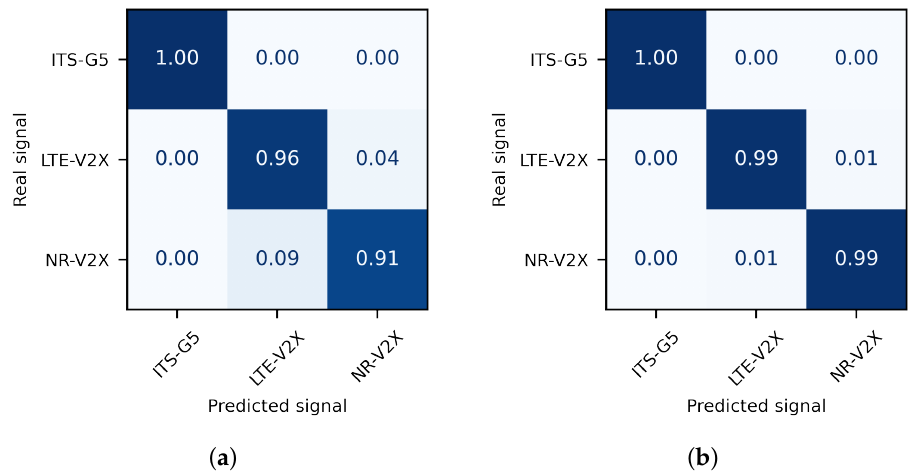
Figure 4. Confusion matrix of ( a ) SCF with SVM and ( b ) IF with random forest techniques.